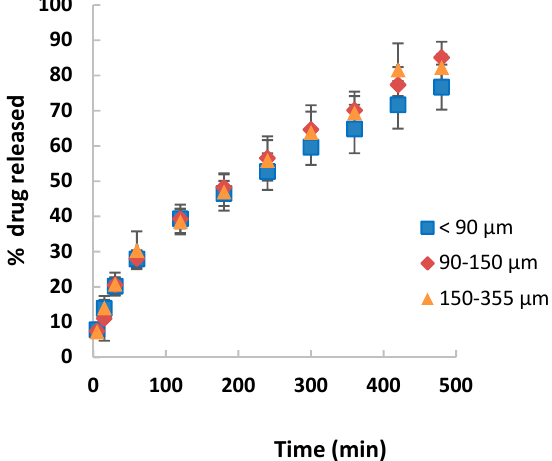
Figure 1. Drug release profiles of thermoplastic polyurethanes (TPU) tablets with different drug particle size.